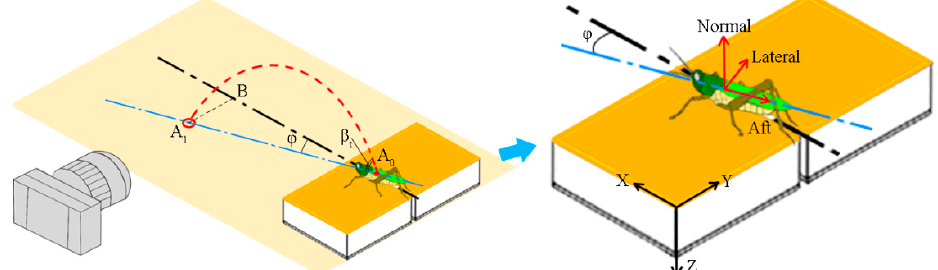
Figure 2 . Schematic diagram illustrating how the kinematics and reaction force of the locust jumps were calculated. Because of the yaw angle ( φ ), the real trajectory of the jump was corrected from the image recordings of the sideway high-speed camera. The jump direction and real trajectory of the locust are indicated by the blue and red dashed lines, respectively. The black dashed line is parallel to both the lateral camera and the direction X of the force sensor. A 0 : the initial locust position; A 1 : the real locust position after jumping; B: the locust position in the camera images after jumping; and β t : the elevation angle of the locust at take-off. Similarly, the physiological components of the reaction force were transformed from the sensor measurements using the yaw angle. The coordinate system of the force sensor is shown by black axes, and the physiological coordinate system of the locust is shown by red axes.